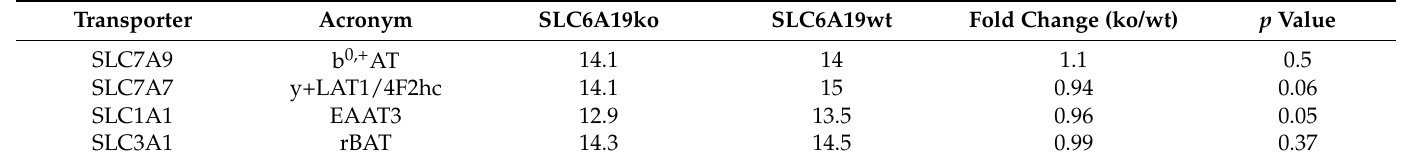
Table 3. Microarray analysis of other SLC transporters present in kidney.